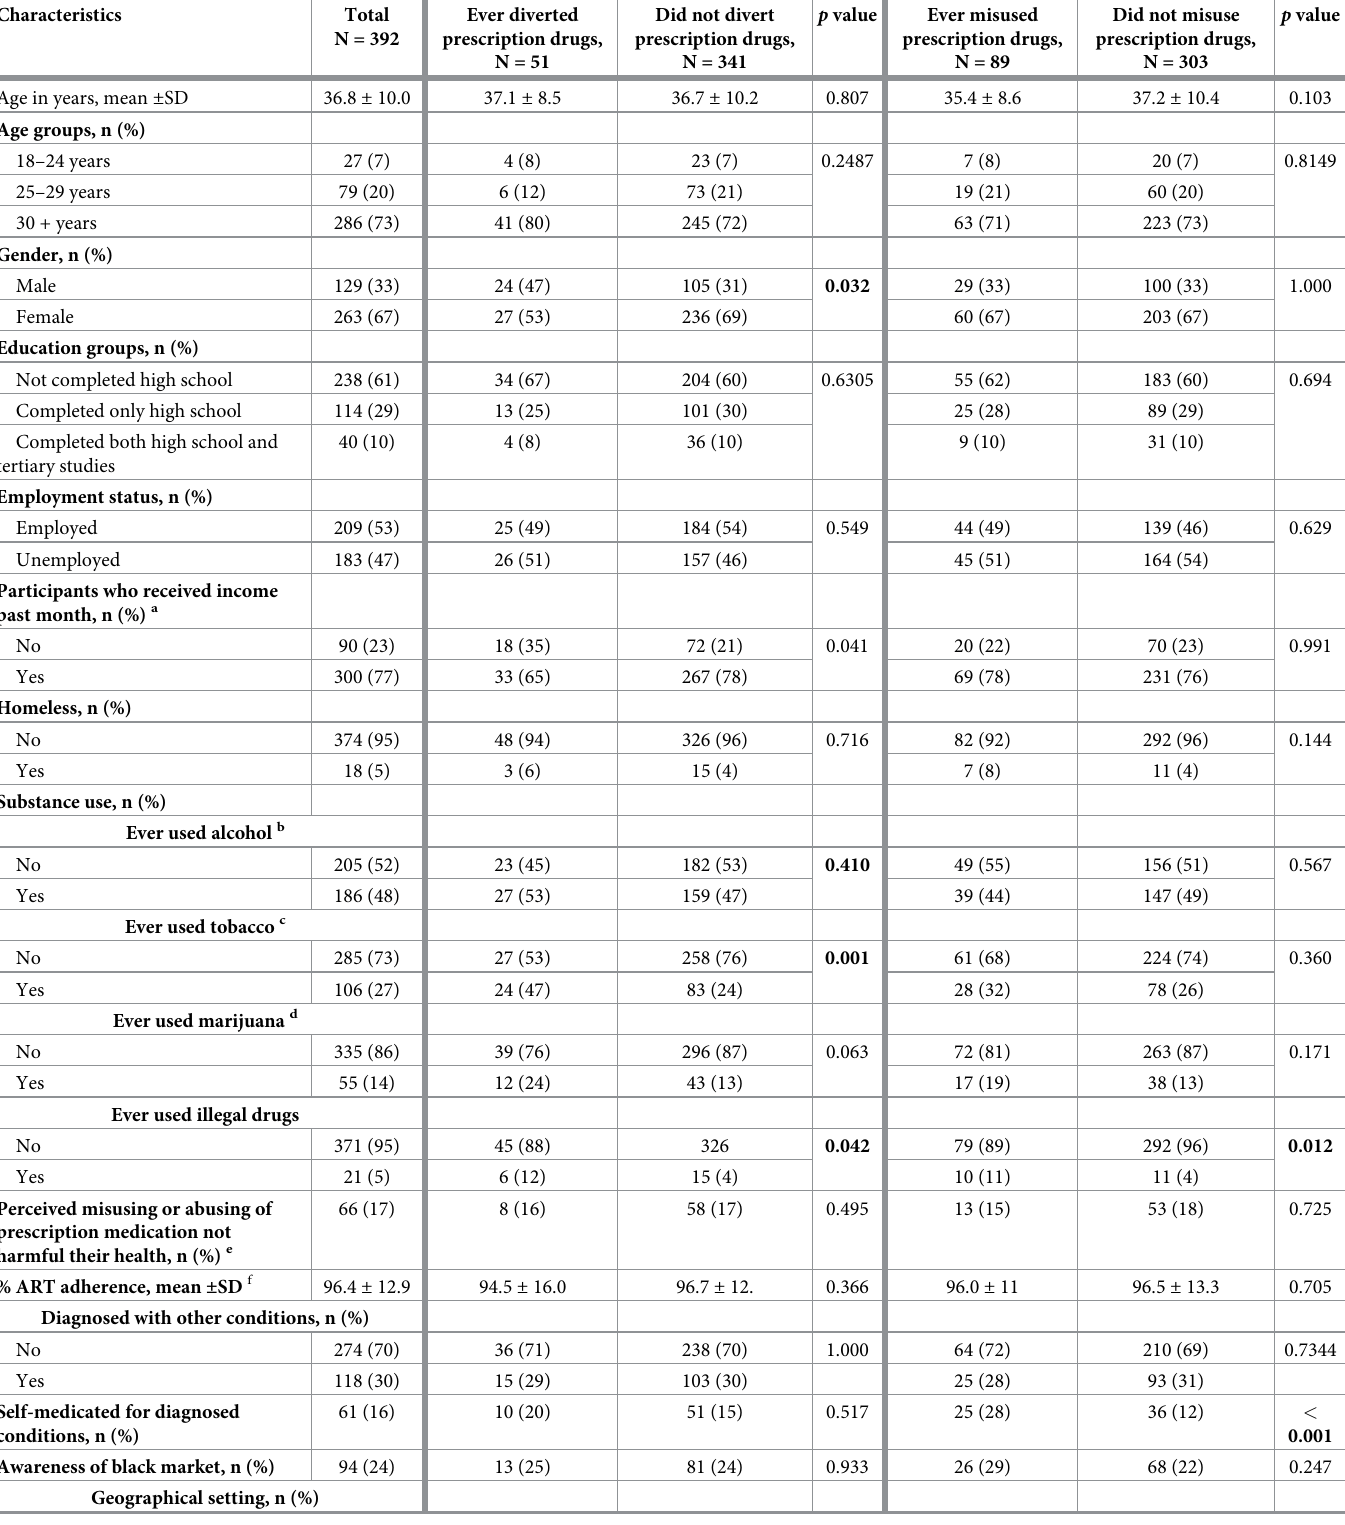
Table 1. Participants characteristics stratified by prescription drug diversion and misuse.